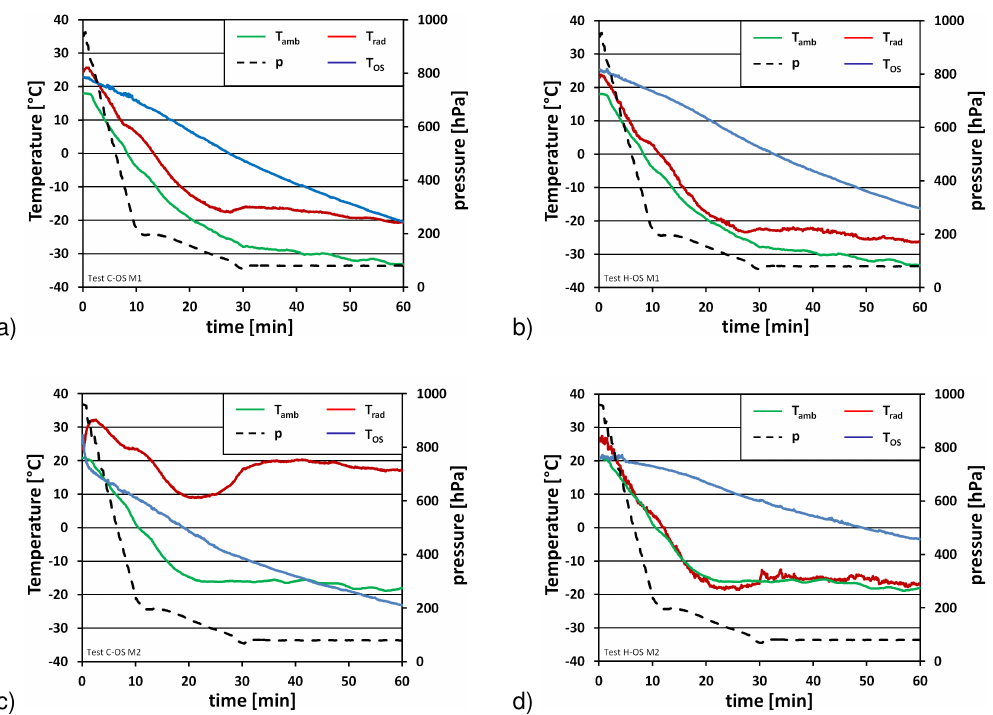
Fig. 13. Thermal behaviour during ascent simulation test. Upper panel: Scenario No. 1 (cold instrument compartment, final T amb = − 33 ◦ C) of (a) GBB-C optical surface with TEC power < 50 W and (b) GBB-H optical surface with TEC power < 25 W . Lower panel: Scenario No. 2 (warm instrument compartment, final T amb = − 18 ◦ C) of (c) GBB-C optical surface with TEC power < 120 W and (d) GBB-H optical surface with TEC power = 0 W . 46